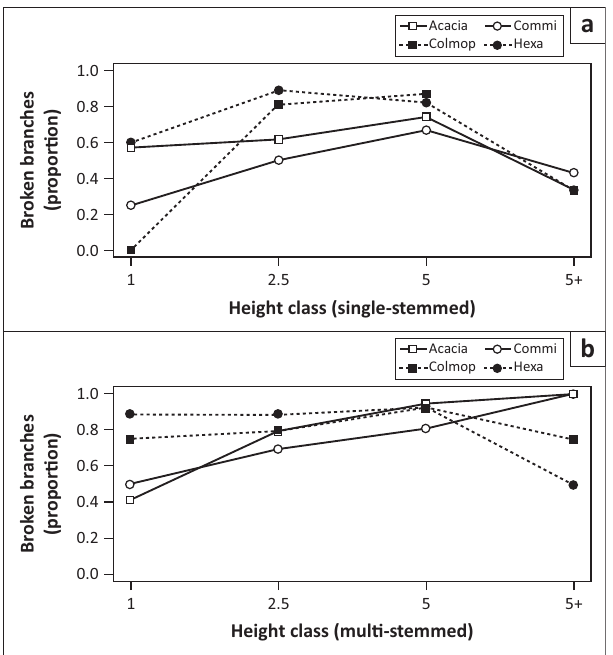
FIGURE 4: Proportion of plants with broken branches among vegetation types for (a) single-stemmed plants and (b) multi-stemmed plants.